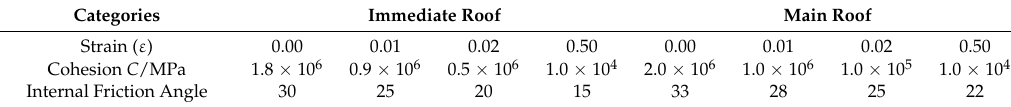
Table 6. The softening parameters of backfilling rocks.